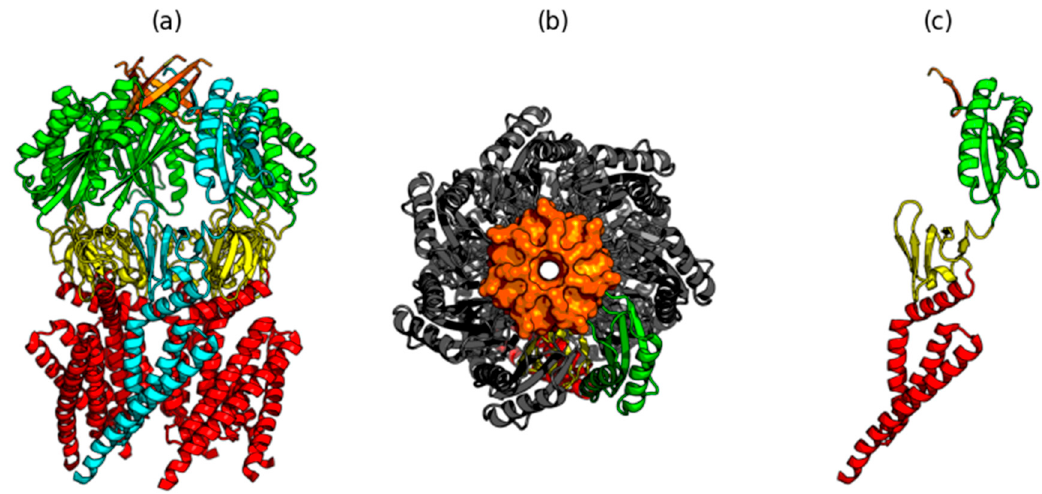
Figure 4. 3D structure od MscS (PDB ID 2VV5). ( a ) red—dom1 (25–128), yellow—dom2 (129–181), green—dom3 (182–270), orange—dom4—beta-barrel (271–278), chain A distinguished as blue, ( b ) other orientations of the complex, gray—chains B–E, chain A—green, ( c )—single chain—colors as in ( a ).